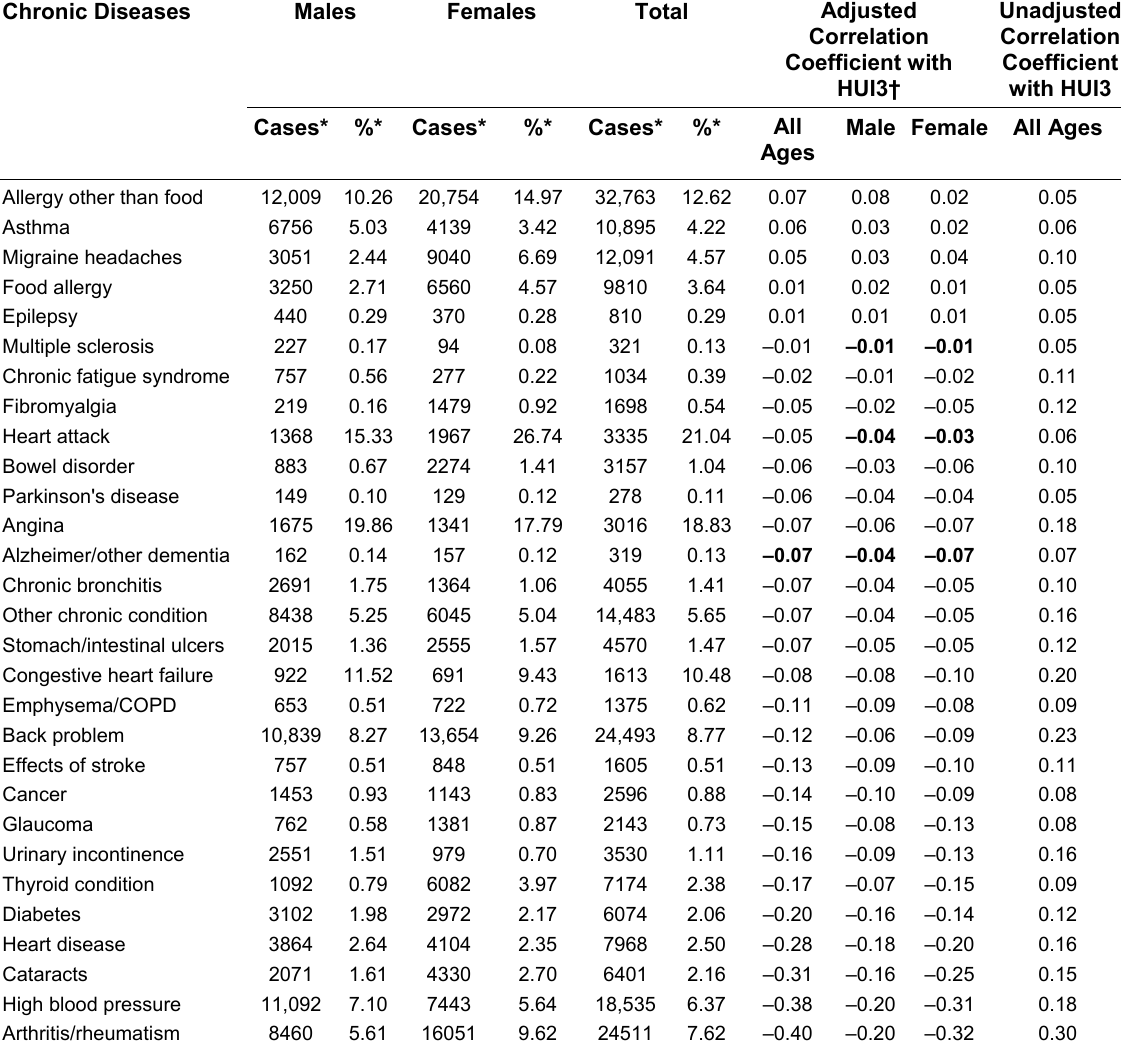
Number of Cases, Percent, and Correlation Coefficient with HUI3 Scores of Selected Chronic Conditions by Gender, Household Population Aged 12 and Over Chronic Diseases Males Females